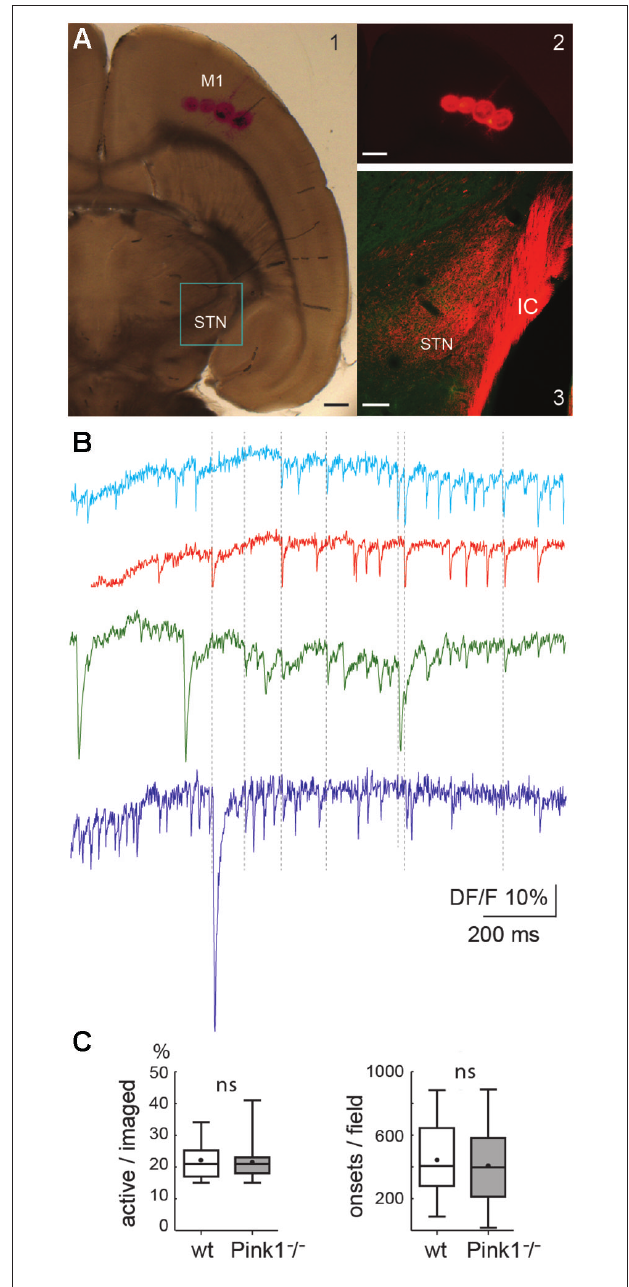
FIGURE 1 | The cortico-subthalamic slice. (A) Four DiI injections in M1 cortex in the slice ( A1 , transmission light photo and A2 , fluorescent image, both just after the injection) and DiI-labeled cortical axons observed 15 days later in the internal capsule (IC) and STN ( A3 , confocal image superposing DiI labeling (red) and Pitx2 labeling (green)). Scale bars A1 and A2: 500 µ m; A3: 150 µ m. (B) Calcium dynamics from a sample of four neurons. Vertical dotted lines indicate some of the synchronous calcium transients. Total duration = 137 s. (C) Percent of active cells from all imaged cells (left) and number of onsets of calcium transients from these active cells (right) in wild-type (wt) ( n = 30) and PINK1 − / − ( n = 39) M1 imaged fields. In this and subsequent figures, unless otherwise stated, the bottom and the top of the boxes are the first and third quartiles, the band inside is the median and the point is the mean, the ends of the whiskers are the minimum and the maximum of all the